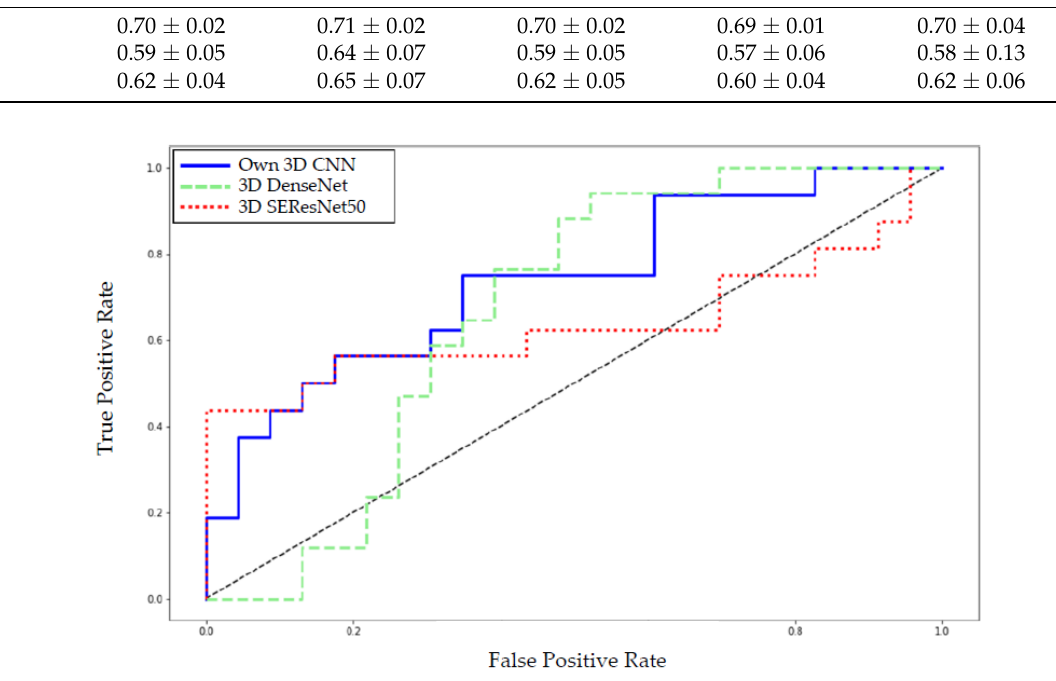
Figure 8. The decision curve analysis for the best run of the novel 3D CNN shows that within the threshold probability from 30% to 65% checking patients based on the classification model leads to a higher benefit than checking no or checking all lymphomas more frequently. 3.4. Comparing the Deep Neural Network with the Machine Learning Approach Figure 9 illustrates the metrics grouped by each data set and presents them as grouped bar charts for clarity and ranking of the different deep neural networks and ma- chine learning models.